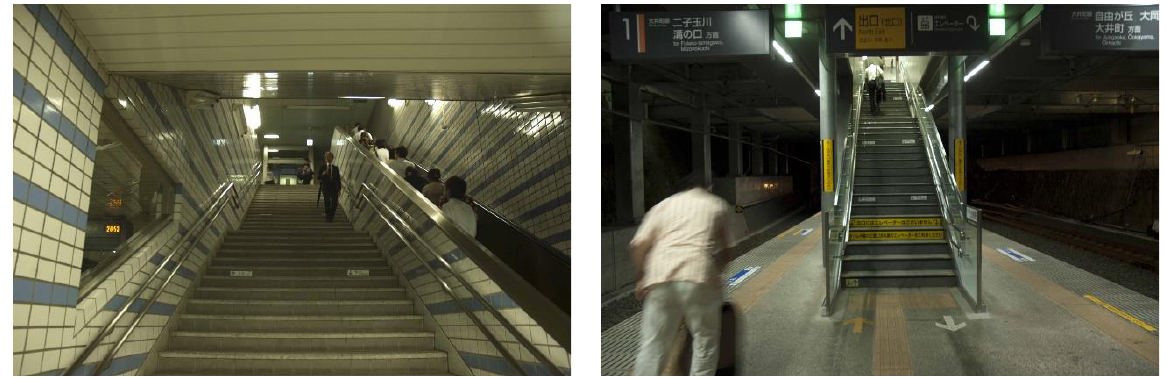
Figure 5. Comparison of maximum and minimum points of vertical illuminance (( left ): No. 20, ( right ): No. 19).